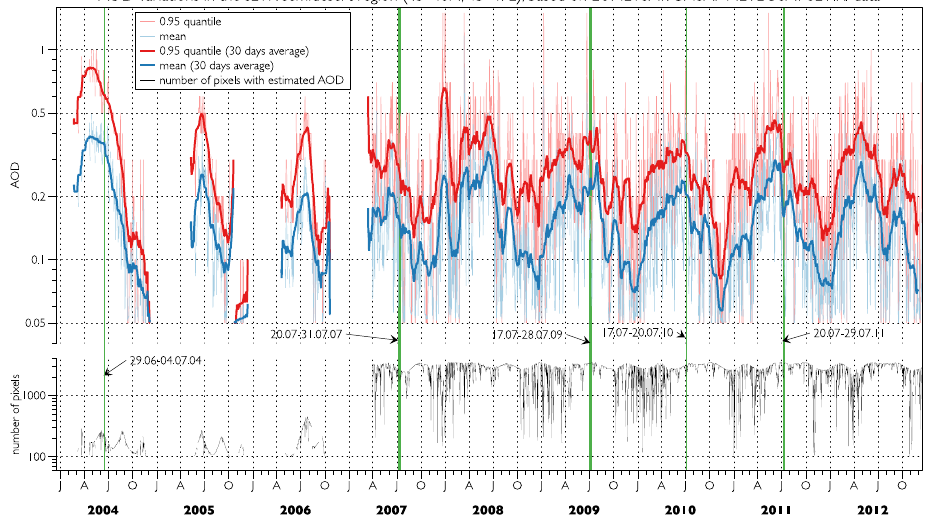
Figure 5. Daily AODs according to the data of the EUMETSAT-CMSAF product based on the SEVIRI instrument on the METEOSAT satellite [59] for the arid region of the southern ETR (45–48° N, 43– 47° E). Thin lines show daily AODs (regional average (blue) and 0.95 quantile (red)), thick lines— moving average for 30 days. Values were defined only for the days for when region AODs was defined for at least 100 pixels. The black line shows the number of pixels involved into calculations (the ‘jump’ in 2007 is associated with the changing of the METEOSAT-8 satellite with the new one, METEOSAT-9). Vertical green lines mark the months of field campaigns.